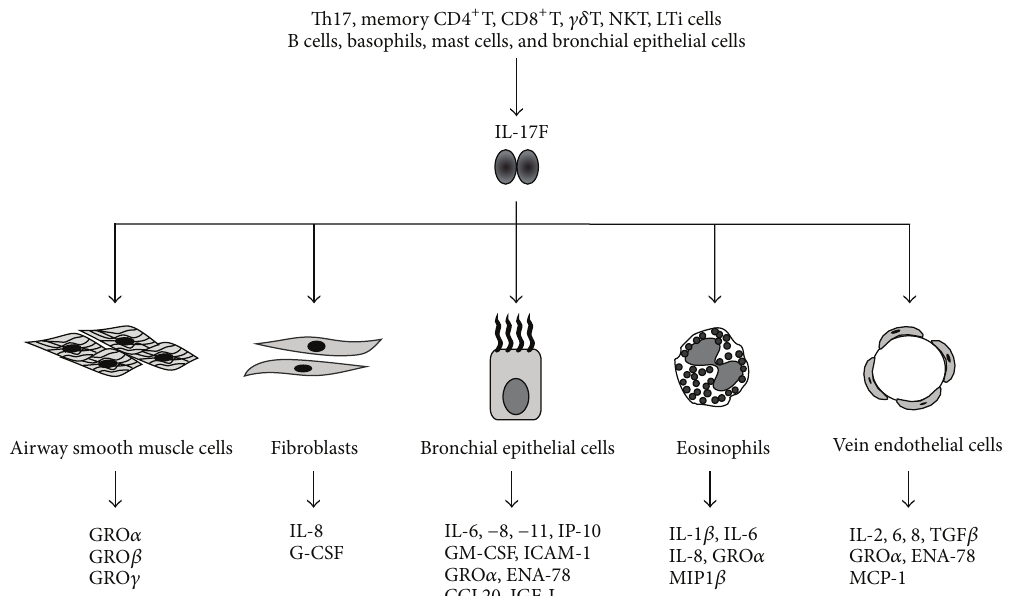
Figure 1: Biological activities of IL-17F. IL-17F has multiple biological activities. IL-17F is produced by several cell types including Th17 cells andbronchialepithelialcells.IL-17Fcaninducevariousasthma-relatedcytokines,chemokines,andadhesionmoleculesinbronchialepithelial cells, eosinophils, fibroblasts, airway smooth muscle cells, and vein endothelial cells, and thereby contributes to the pathogenesis of